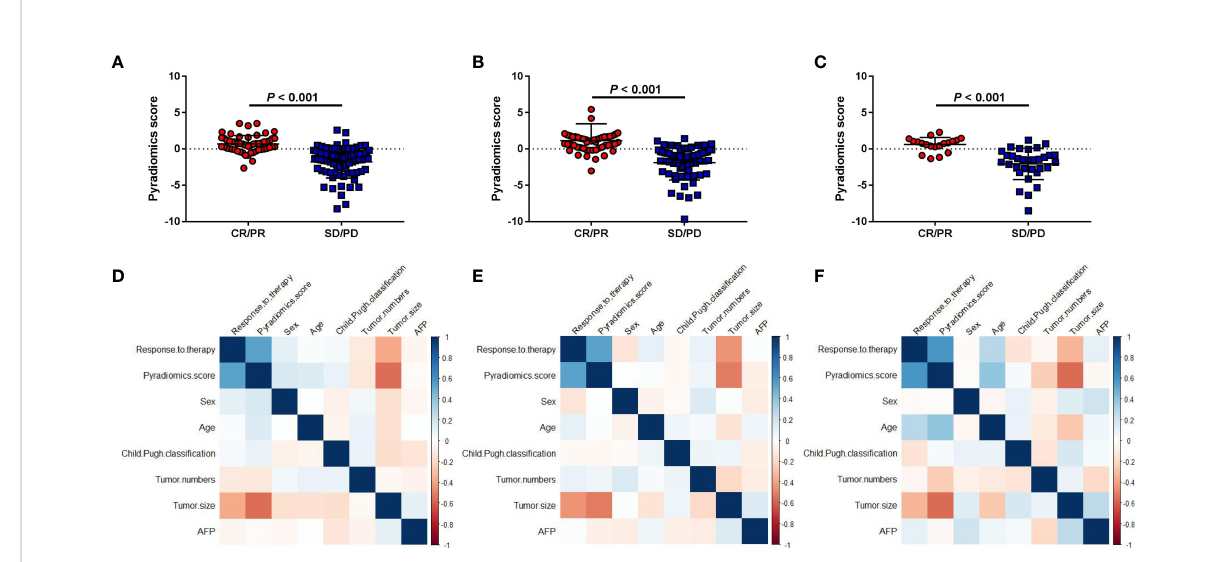
FIGURE 2 Association between the pyradiomics score and clinical factors. (A-C) Correlations between the pyradiomics score and object response (CR+PR) in the discovery and two validation sets. (D-F) Correlation heatmaps of the pyradiomics score and clinical factors in the three cohorts. SD, stable disease; CR, complete response; PD, progressive disease; PR, partial response.